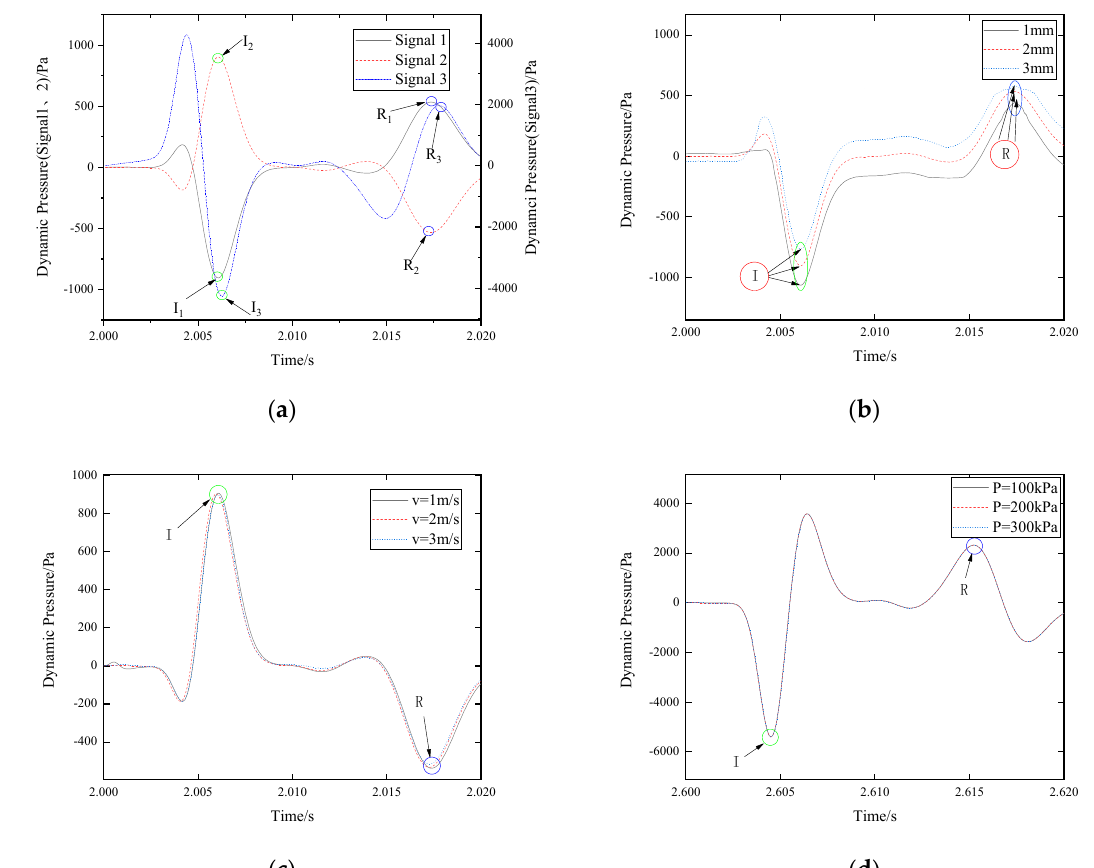
Figure 15. Dynamic pressure responses under different conditions (where I and R represent disturbance signal and reflection signal respectively): ( a ) different disturbance signal; ( b ) different leakage hole size; ( c ) different stable flow; and ( d ) different operation pressure.